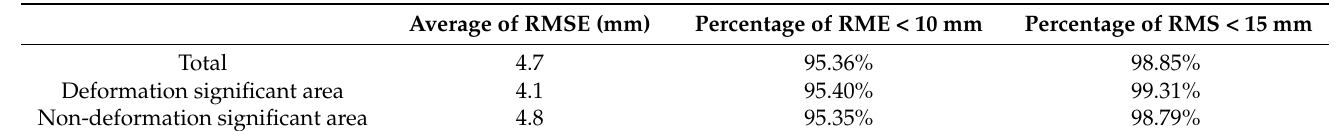
Figure 13. Root mean square error chart. ( a ) Total mean square error; ( b ) deformation significant regional mean square error; ( c ) deformation non-significant area mean square error.